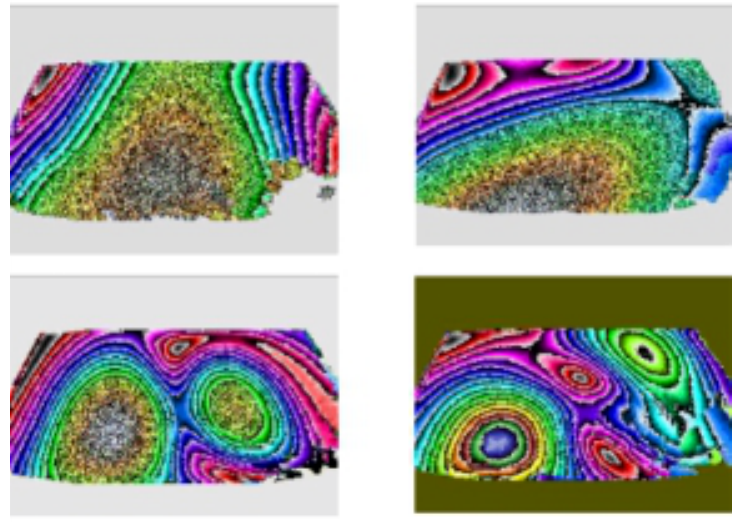
Fig. 17. Operational deflection shape amplitudes at 50 Hz (upper left), 90 Hz (upper right), 120 Hz (lower left) and 160 Hz (lower right). ments by laser techniques, Ancona (I), SPIE volume 2868, September 23–25, 1996, pp.